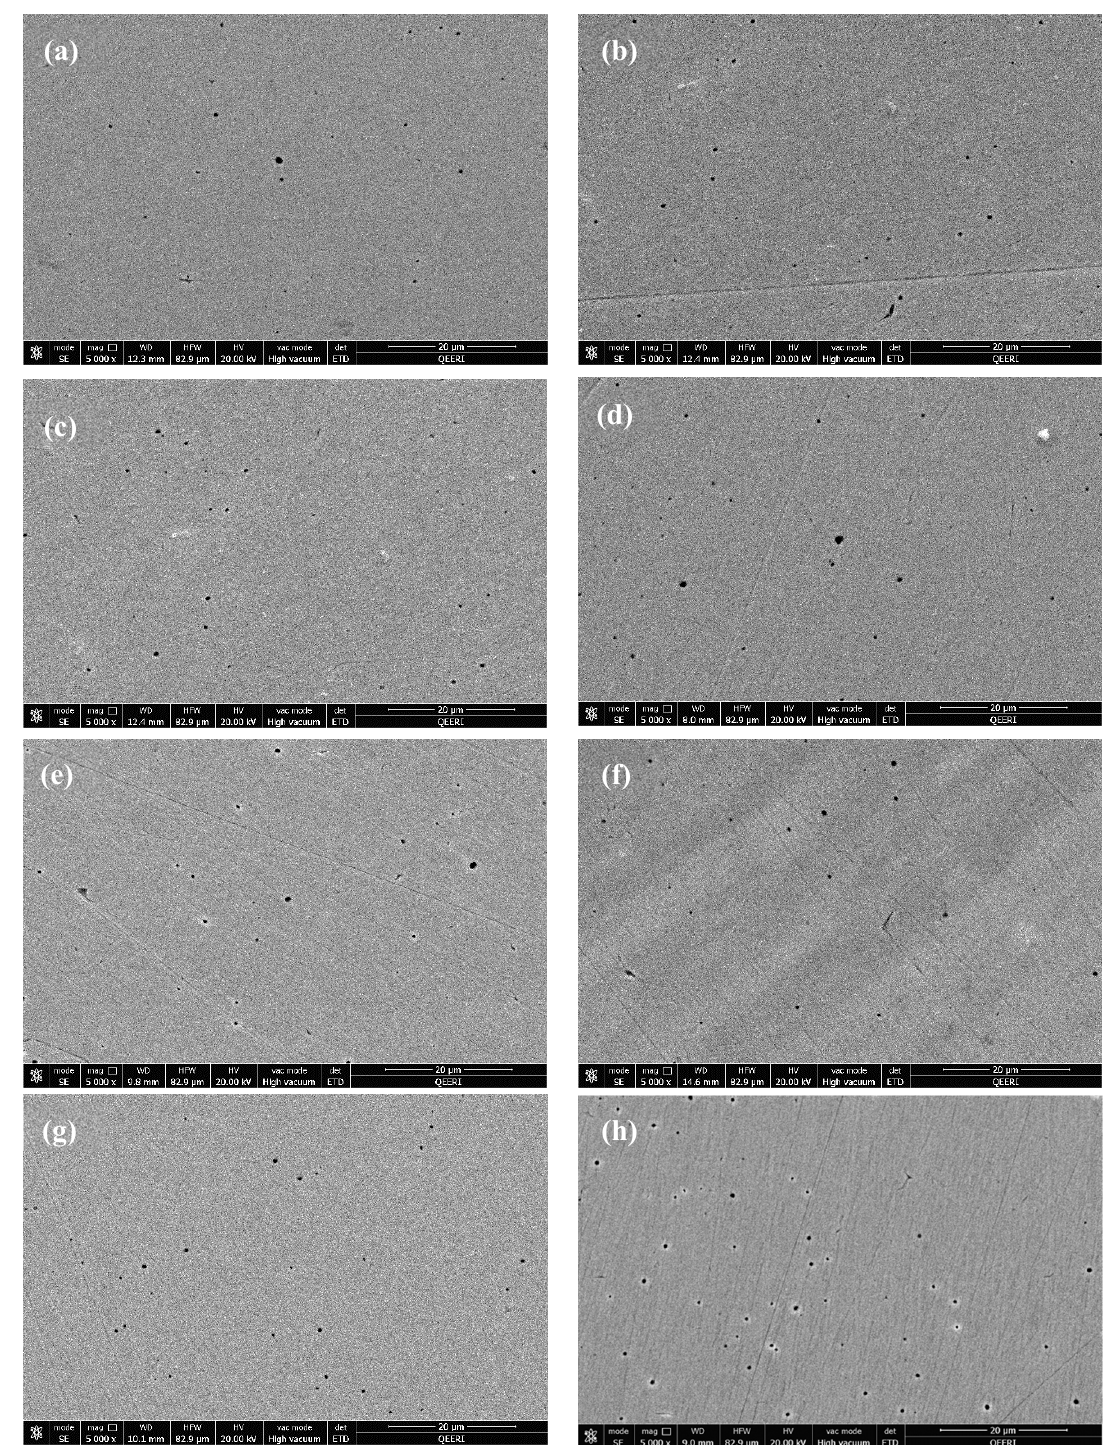
Figure 8. SEM images after washing for 316L stainless steel samples tested in ( a – d ) 0.1 wt.% CNT-water nanofluids at ( a ) 22°C ( b ) 40°C ( c ) 60°C ( d ) 80°C. Figures ( e – h ) tested in 1.0 wt.% CNTs–water nanofluids at ( e ) 22°C ( f ) 40°C ( g ) 60°C ( h ) 80°C.